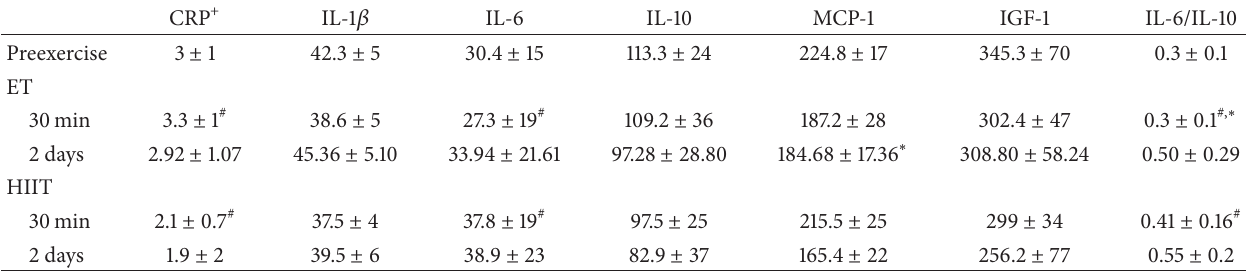
Table 2: Blood marker data prior to and 30min and 2 days after ET and